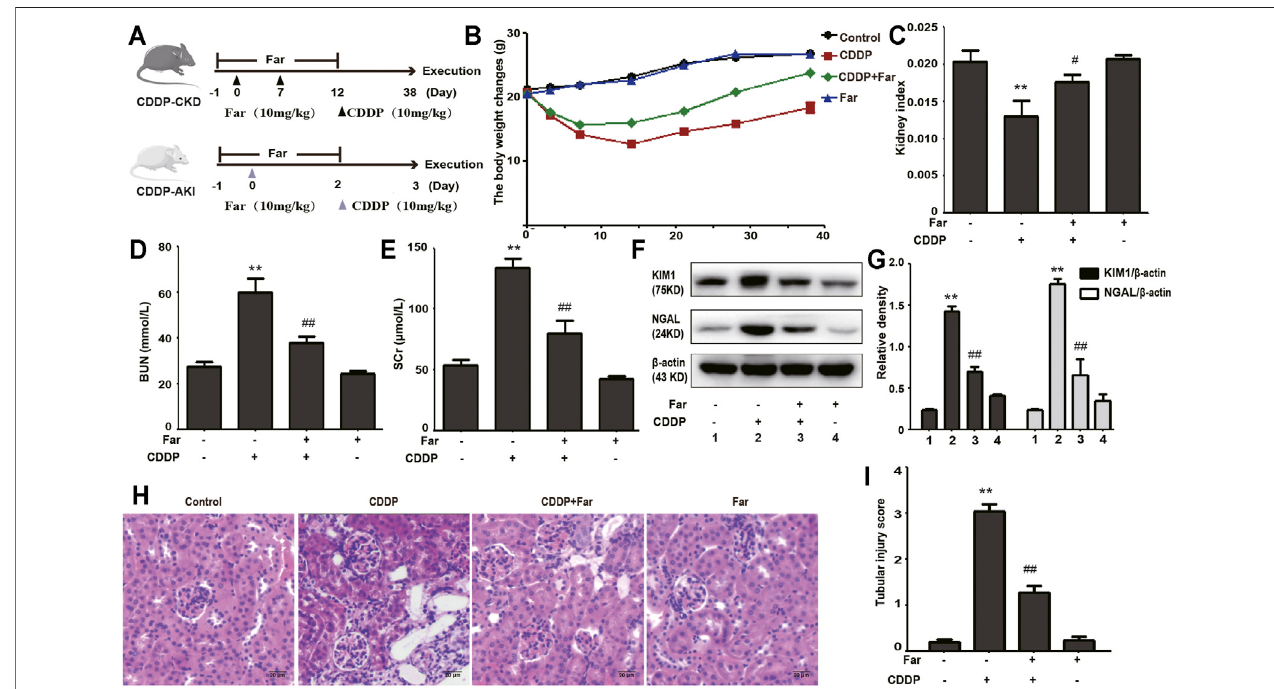
FIGURE 1 | Cisplatin-induced CKD is inhibited by farrerol. (A) The mouse models of CDDP-induced CKD and AKI combined with farrerol were established as follows. CDDP-CKD mouse model: Mice were treated daily with farrerol (10 mg/kg/d) or vehicle beginning 1 day before the fi rst intraperitoneal cisplatin injection until 5 daysafterthesecondcisplatininjection.Subsequently,onthe31stdayfollowingthesecondCDDPadministration,allmicewereeuthanized.CDDP-AKImousemodel: On day 0, mice were given cisplatin (10 mg/kg) or vehicle, and farrerol was given daily from day -1 to day 2. Subsequently, the mice were sacri fi ced 1 day after the last farrerol treatment. (B) The body weight changes were measured by measuring the mouse weights at 0, 3, 7, 14, 21, 28, and 38 days. (C) The kidney index refers to the kidney weight divided by the weight on day 38. BUN (D) and SCr (E) levels were evaluated in whole blood on the 38th day of CDDP treatment. The above data are presented as the mean ± SEM ( n (cid:1) 6 in each group). (F,G) KIM1 and NGAL immunoblotting and densitometry normalized to β -actin protein were applied to assess the degree of renal tubular damage. (H,I) H&E-stained micrographs of kidney sections were used to quantify renal tubular damage. All experiments were performed three times. * p < 0.05 and ** p < 0.01 compared with the control group; # p < 0.05 and ## p < 0.01 compared with the CDDP